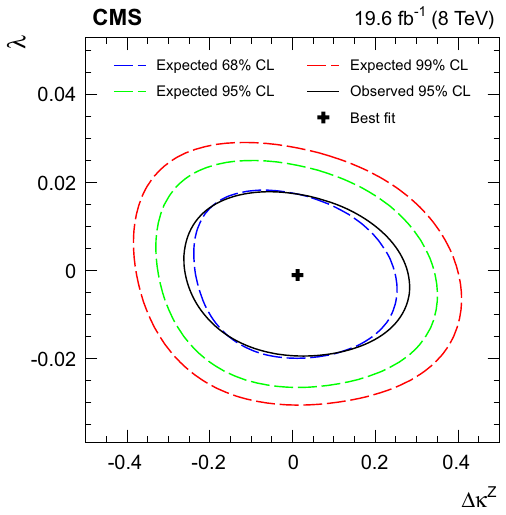
Fig. 10 Two-dimensional observed 95% CL limits and expected 68, 95 and 99% CL limits on anomalous coupling parameters (cid:7)κ Z and λ